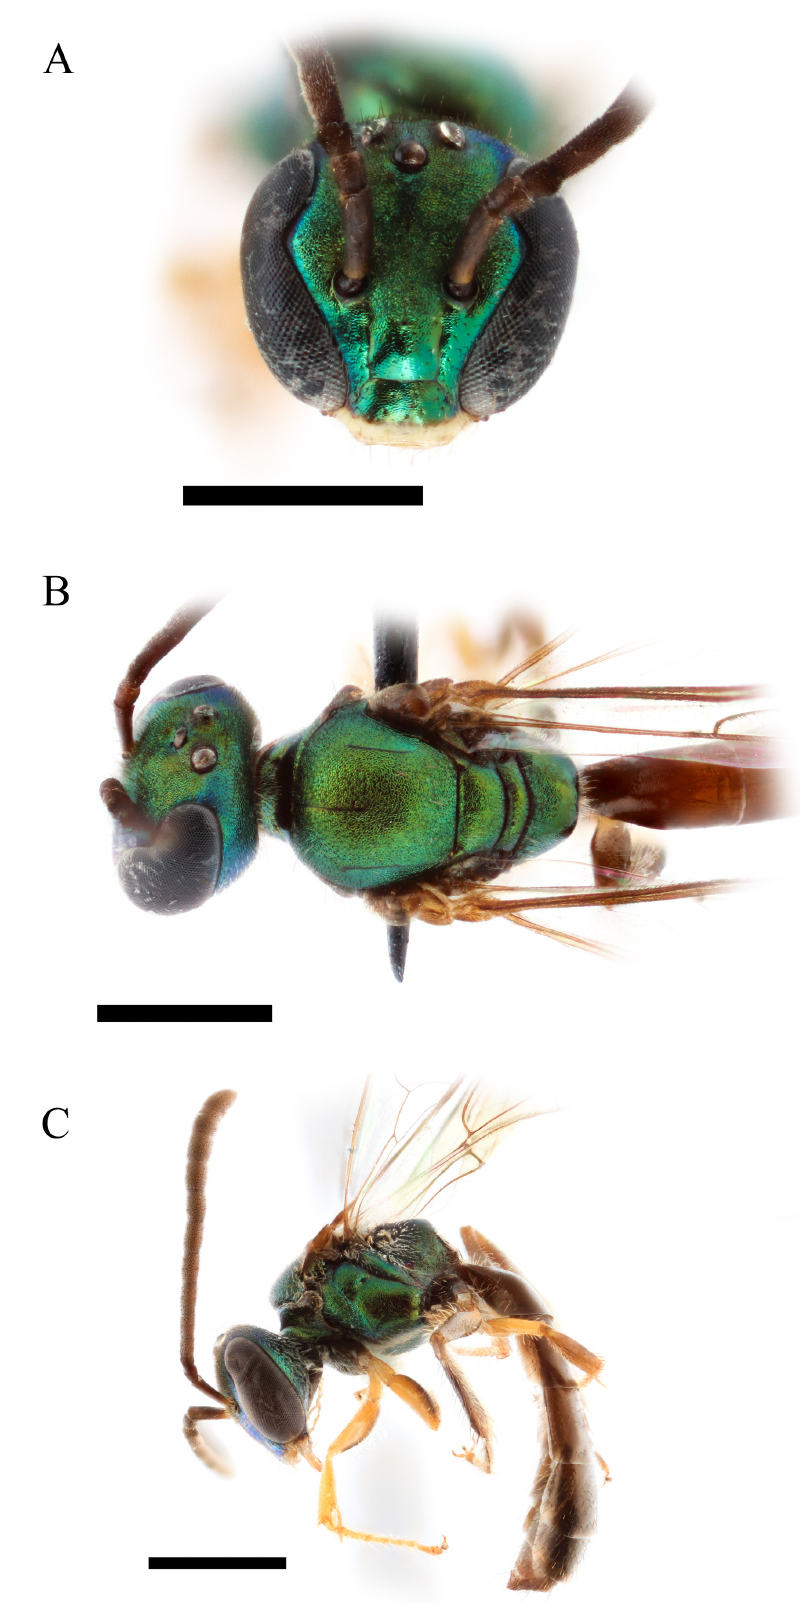
Fig. 21. Habralictus gonzalezi Gibbs, 2012, ♂. A . Face. B . Lateral habitus. C . Dorsum of mesosoma. Scale bars = 1